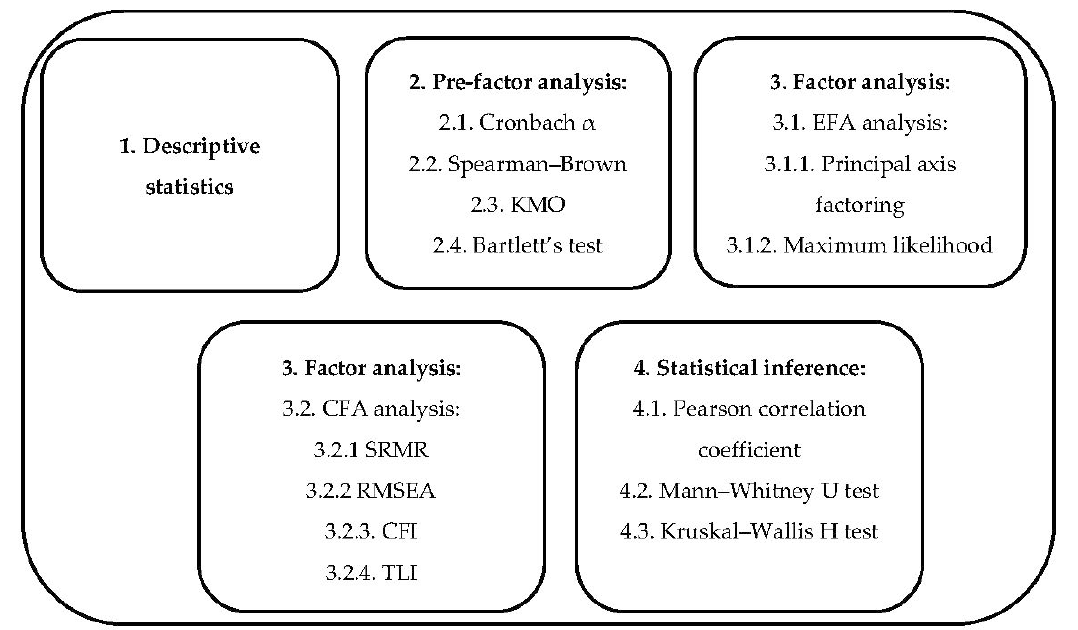
Figure 2. Logical sequence and content of statistical analysis. Source: created by the authors.